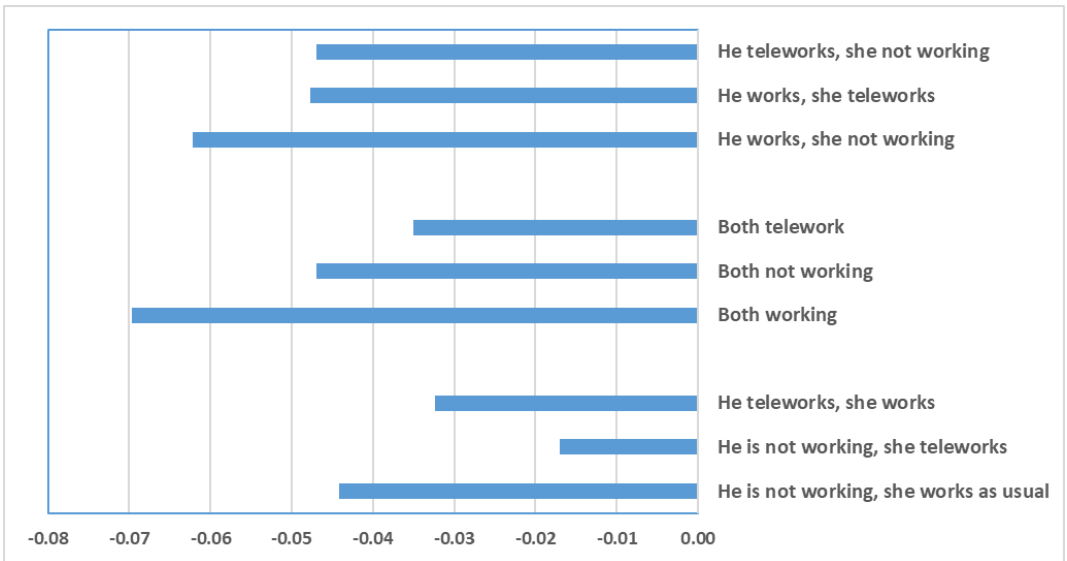
Figure 1. Division of domestic work in different occupational arrangements.